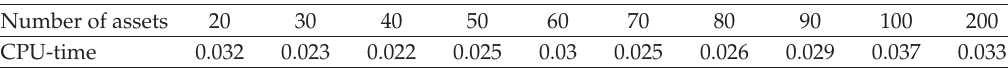
Table 3: CPU-time in seconds per case processed by the KTEF - S algorithm. The results are mean values obtained from ten 30-point samples corresponding to ten di ff erent sets of (cid:6) real (cid:7) data (cid:6) computations have been made with Mathematica (cid:7)